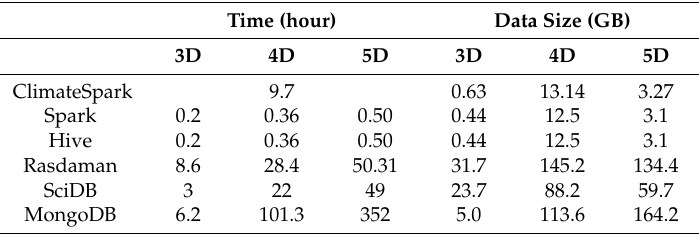
Table 7. Data Uploading Time and Data Size in Container.